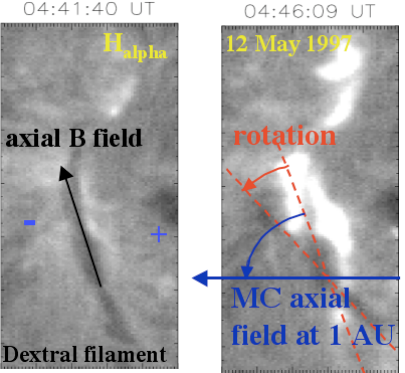
Counterclockwise rotation of an erupting filament on 12 May 1997 (same event as shown on the left panel of Fig. 12). The magnetic configuration has a negative magnetic helicity, as shown by several indicators (see Fig. 16): the dextral filament, the relative shift of flare ribbons, and the associated reverse-S sigmoid observed in X-rays (not shown). The rotation is confirmed by the axis direc- tion of the associated MC at 1 AU (Green et al., 2007).